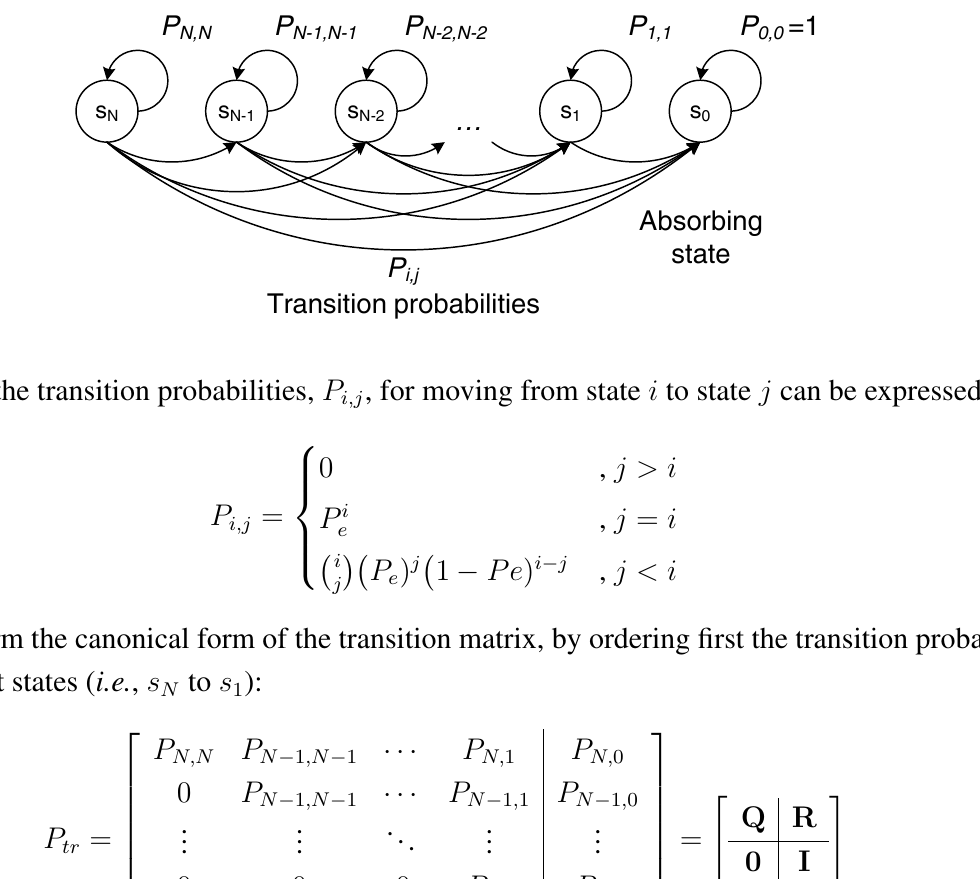
Figure 7. Absorbing Markov chain model for the retransmission